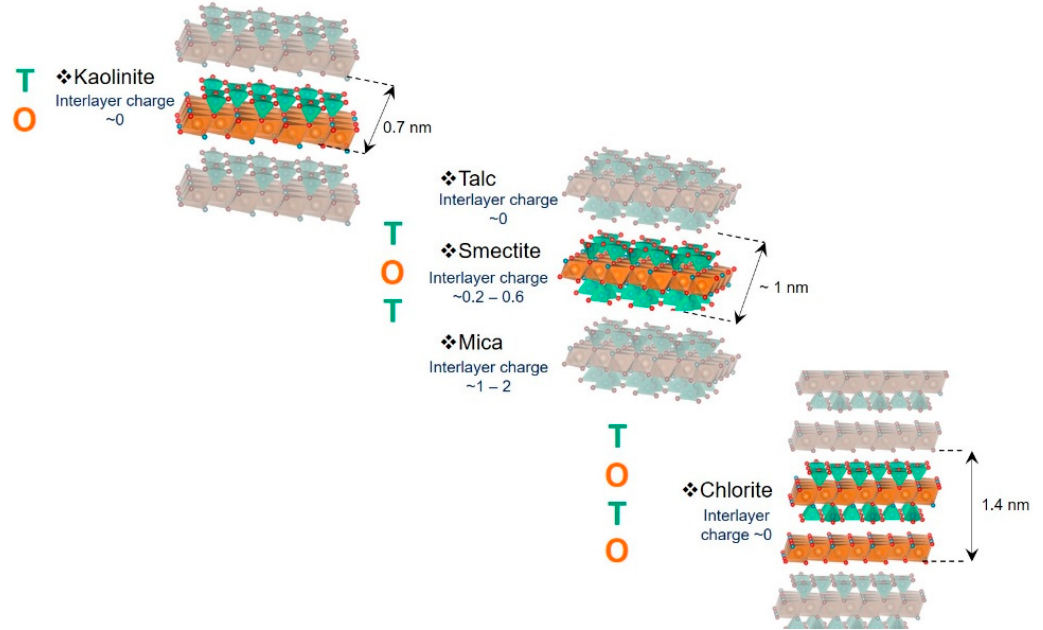
Figure 1. Representation of the three main phyllosilicate families.